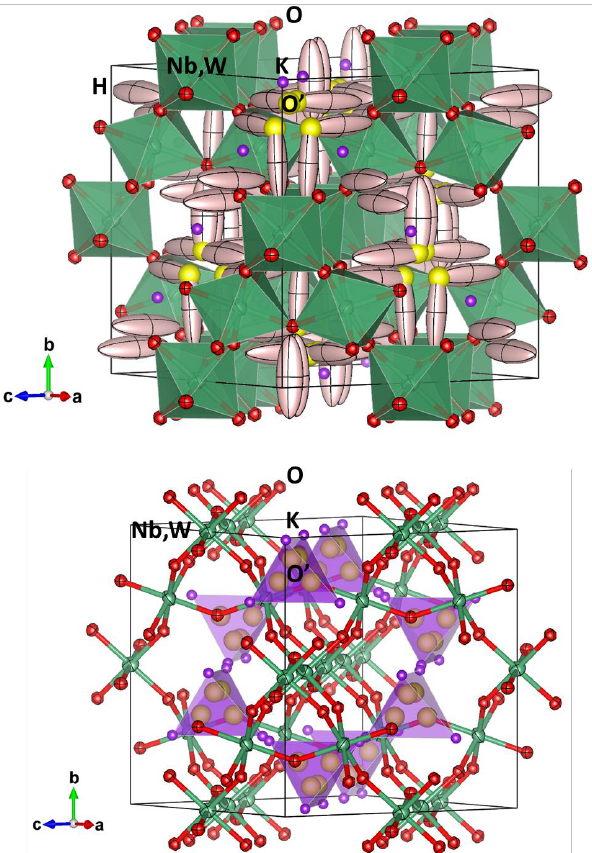
Figure 5. Two views of KNbW pyrochlore structure. ( a ) The main covalent frameworks of (Nb V ,W VI )O 6 octahedra sharing vertices are presented as green cages, forming larger cavities wherein K, H and O’ are distributed at 32 e , 96 g and 32 e Wyckoff sites, respectively. ( b ) A 2 O’sub-lattice of K and O’ atoms highlighted as purple tetrahedra. Only 1 / 4 of the vertices are actually occupied by K